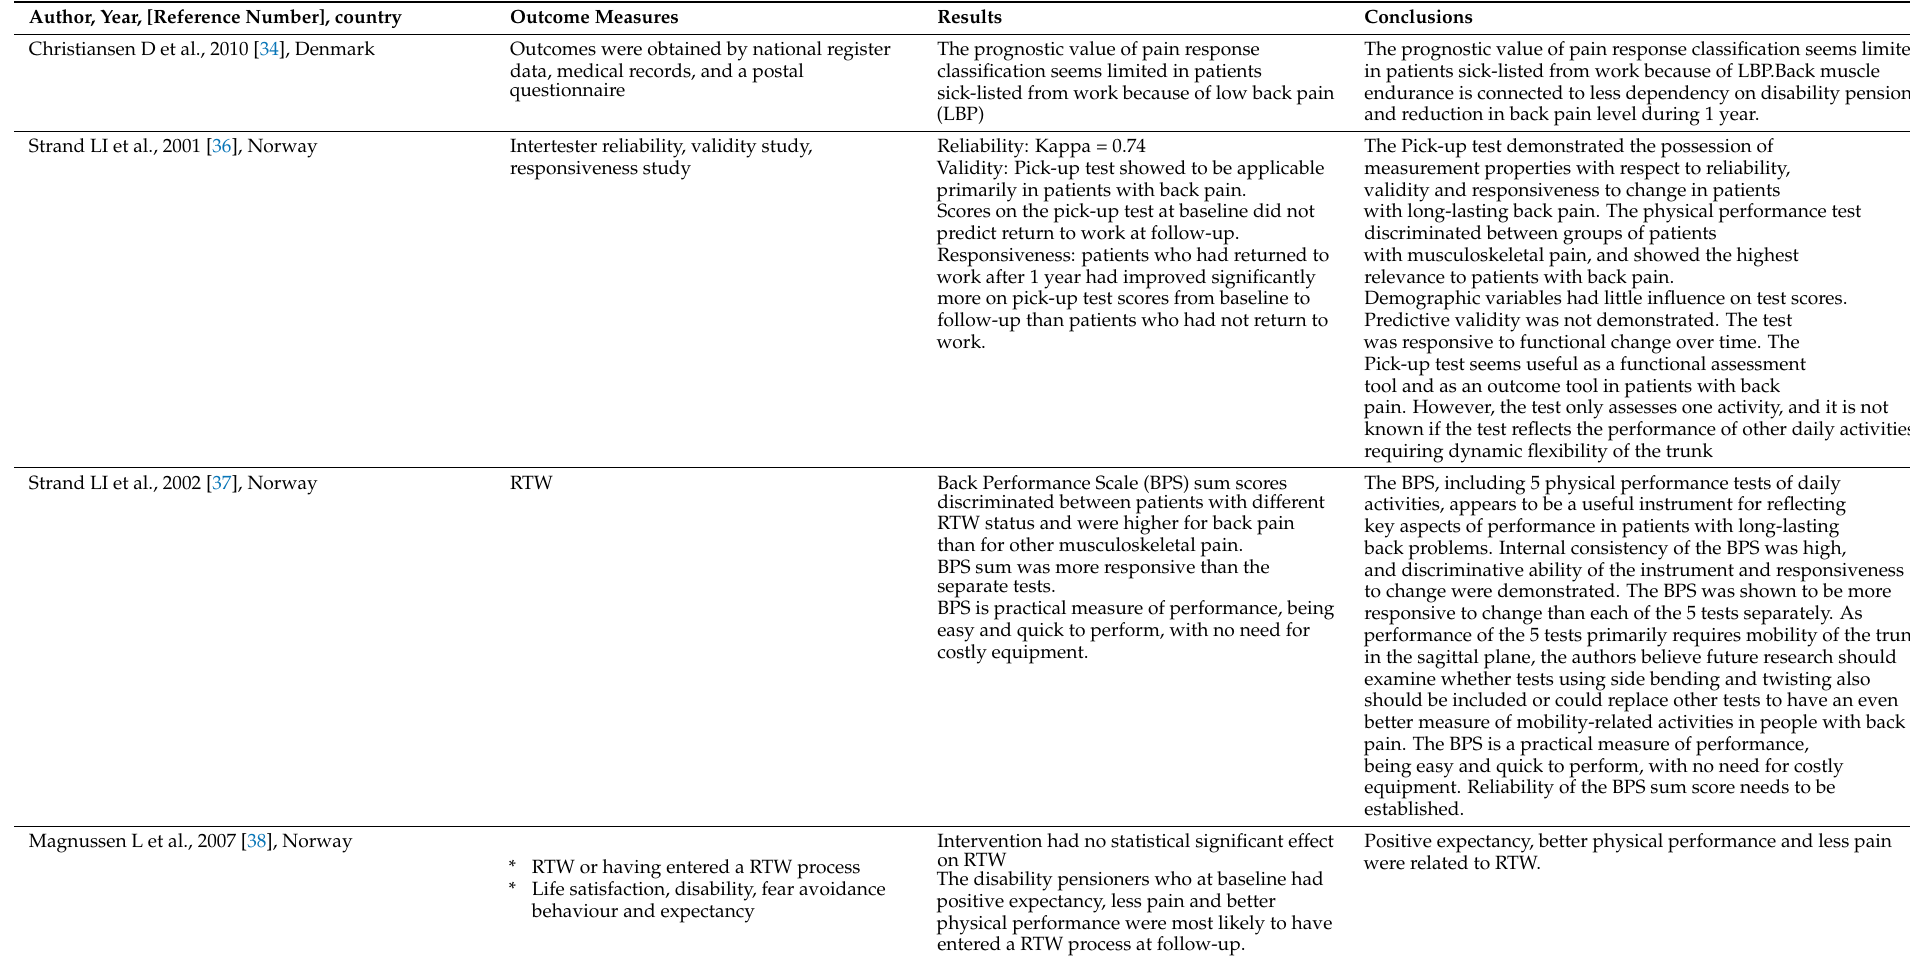
Table 3. Outcome of the included